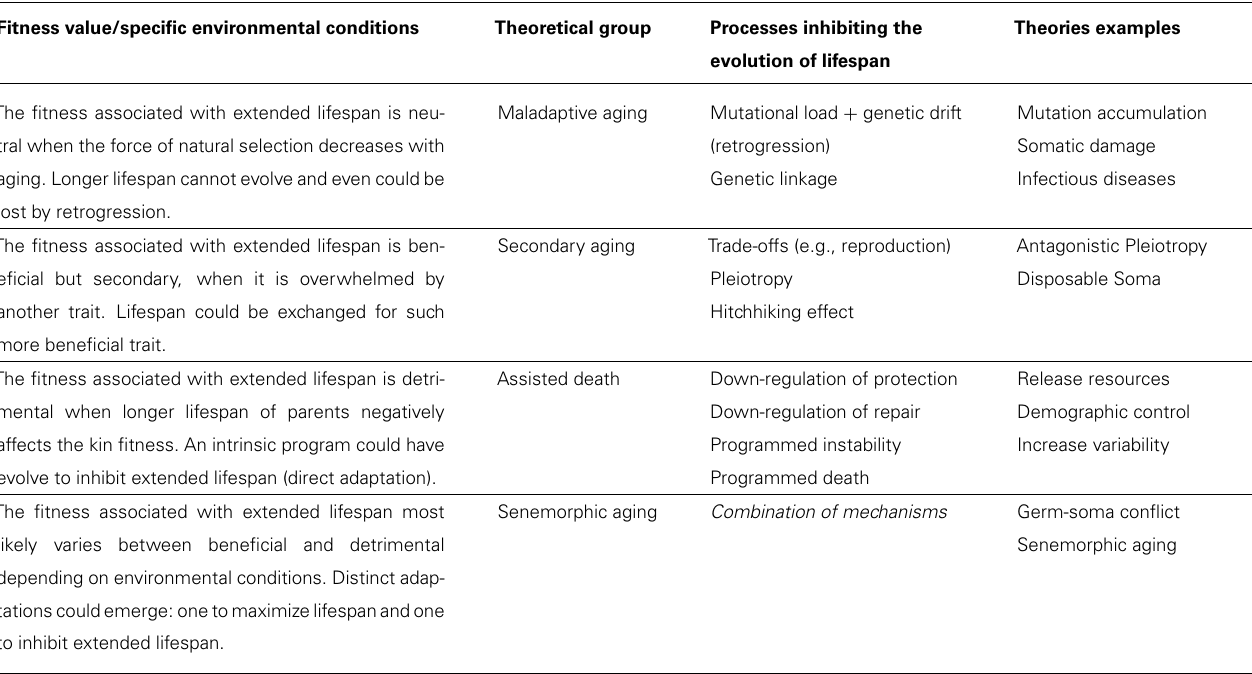
tationscouldemerge: